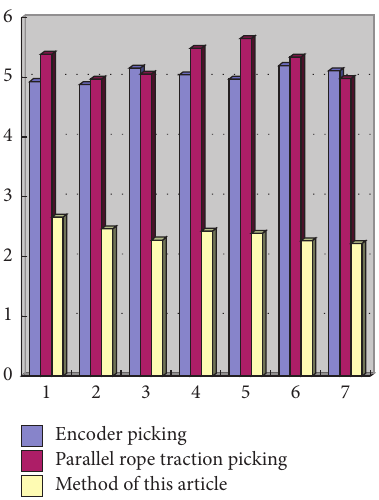
Figure 6: Time comparison results of image recognition with different methods (s).